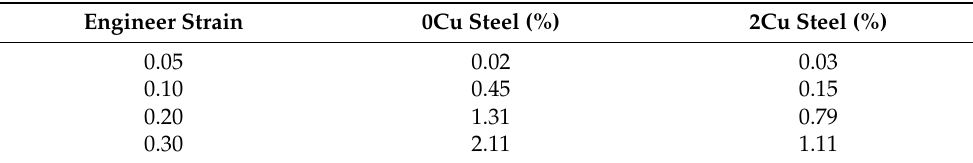
Table 1. The area fraction of the intergranular-fractured region depending on the applied strain for the hydrogencharged 0Cu and 2Cu steels (Reprinted with permission from Ref. [48] Copyright 2022